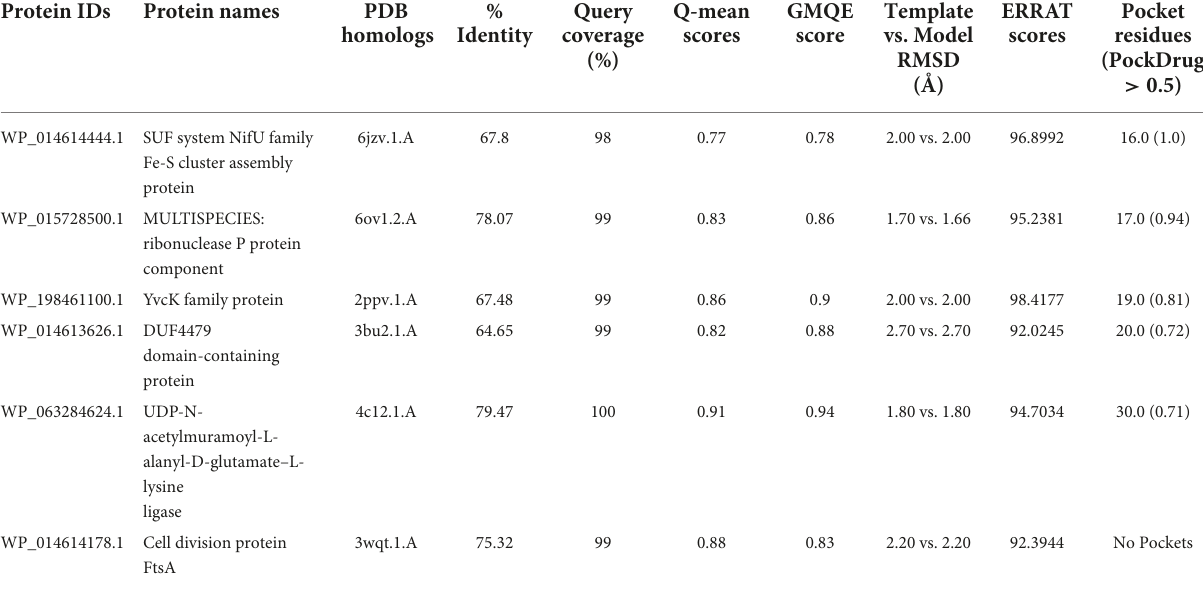
TABLE 3 Druggability screening of the prioritized potential drug